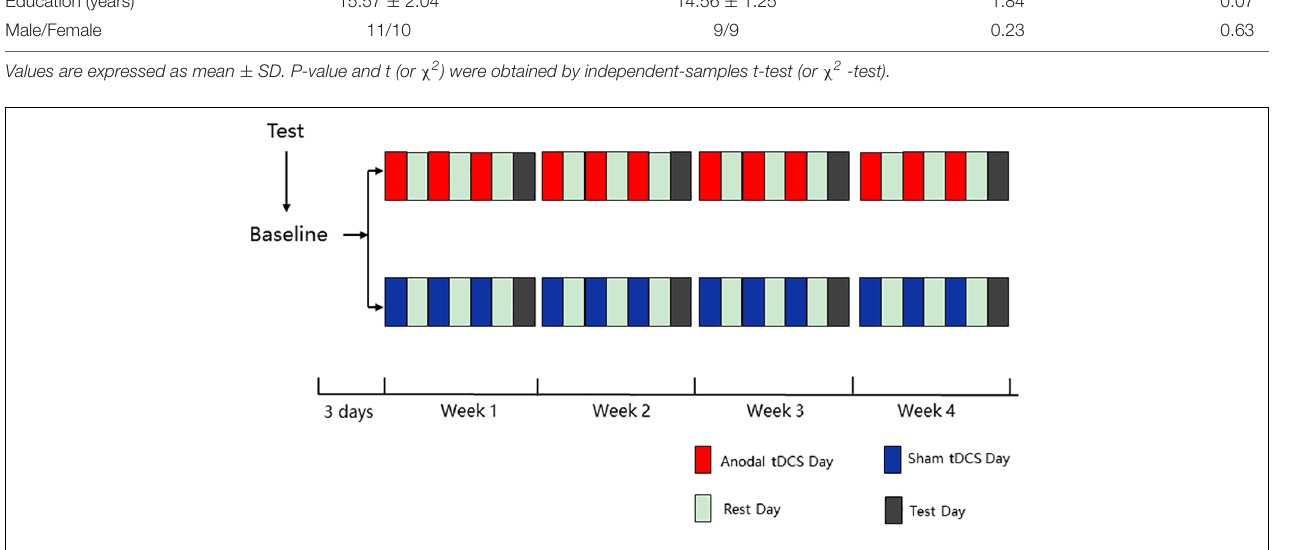
FIGURE 1 | Overview of study